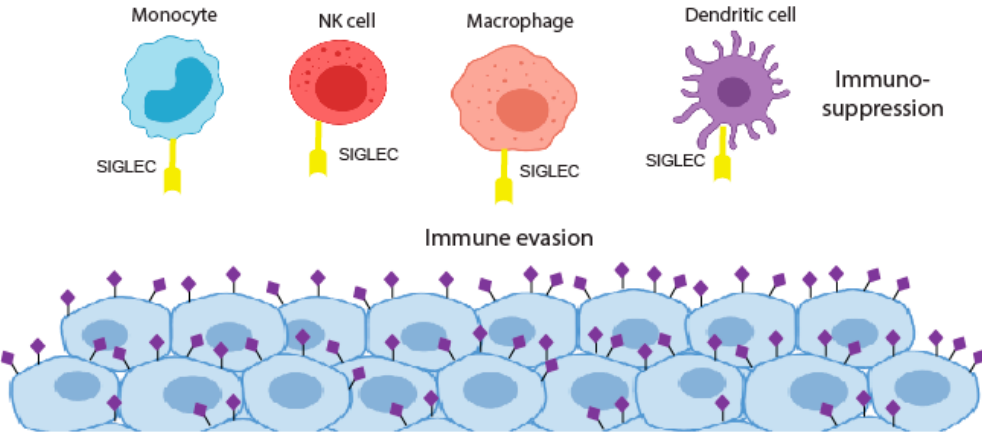
Figure 2. The siglec and sialoglycan axis in cancer. Siglec binding to hypersialylated tumour glycans blocks immune cell activation to promote immunosuppression.